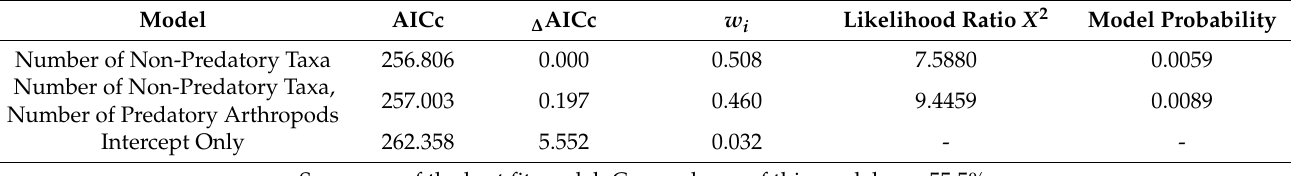
Table 3. Summary of stepwise logistic regression analysis of survival of monarch eggs or larvae based on the abundance and richness of predatory and non-predatory arthropods found on host plants. A stepwise selection procedure was used to generate these models with a significance level for entry into the model set at 0.30 and significance level for removal from the model set at 0.35. Models are sorted in order of ascending AICc. The best model is based on minimum corrected AIC Score (AICc), w i is the Akaike weight of each